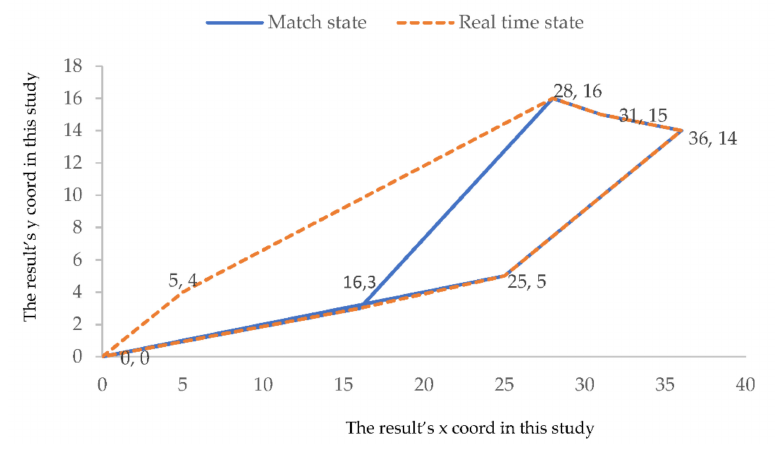
Figure 5. Difference result between match state and real-time